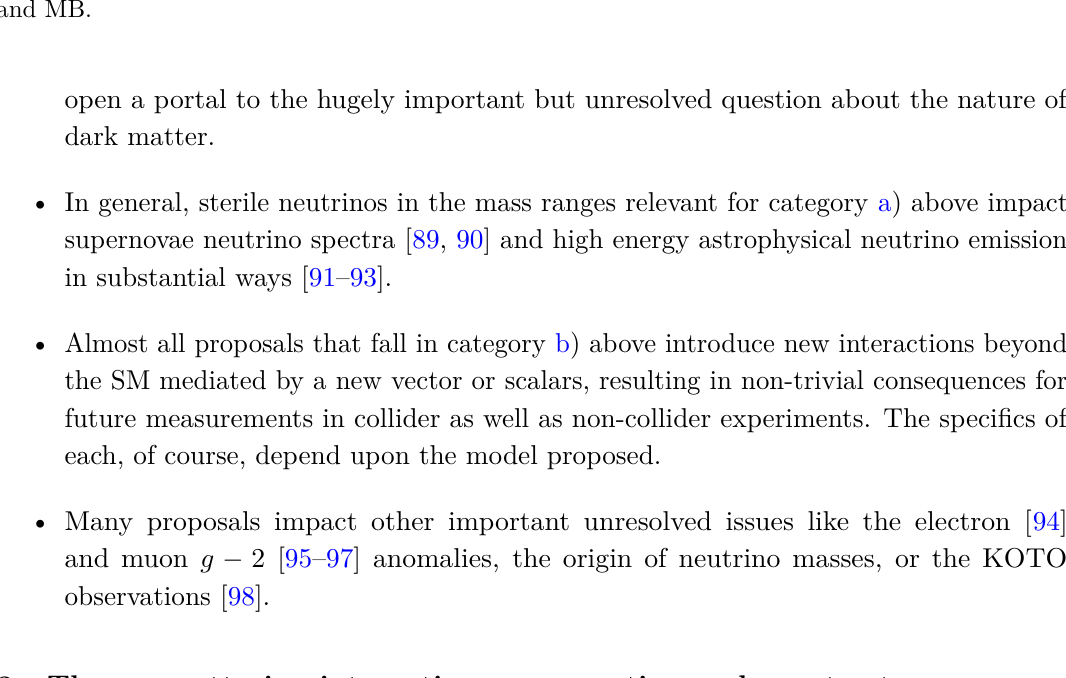
Figure 1. Feynman diagrams for the production and the subsequent decay of the N 2 in LSND and